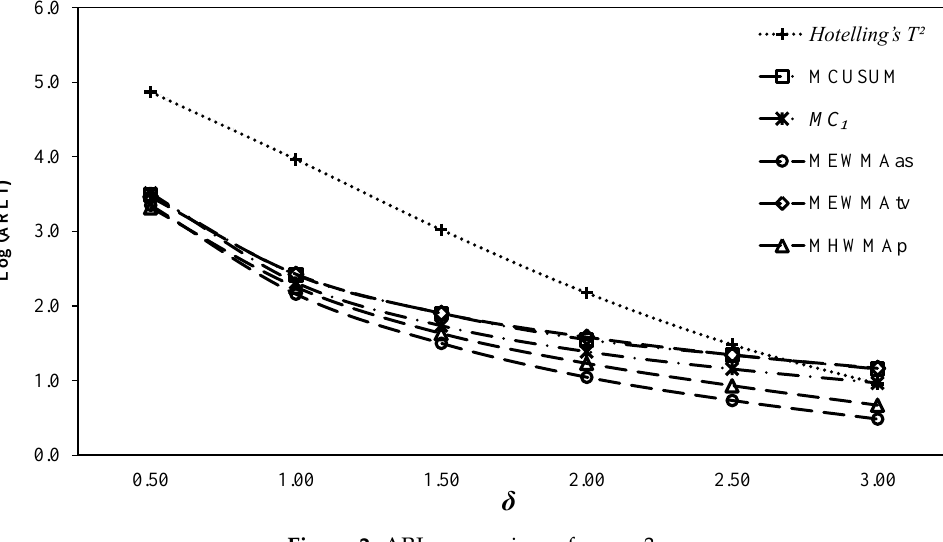
Figure 2. ARL comparisons for 𝑝 = 3 .